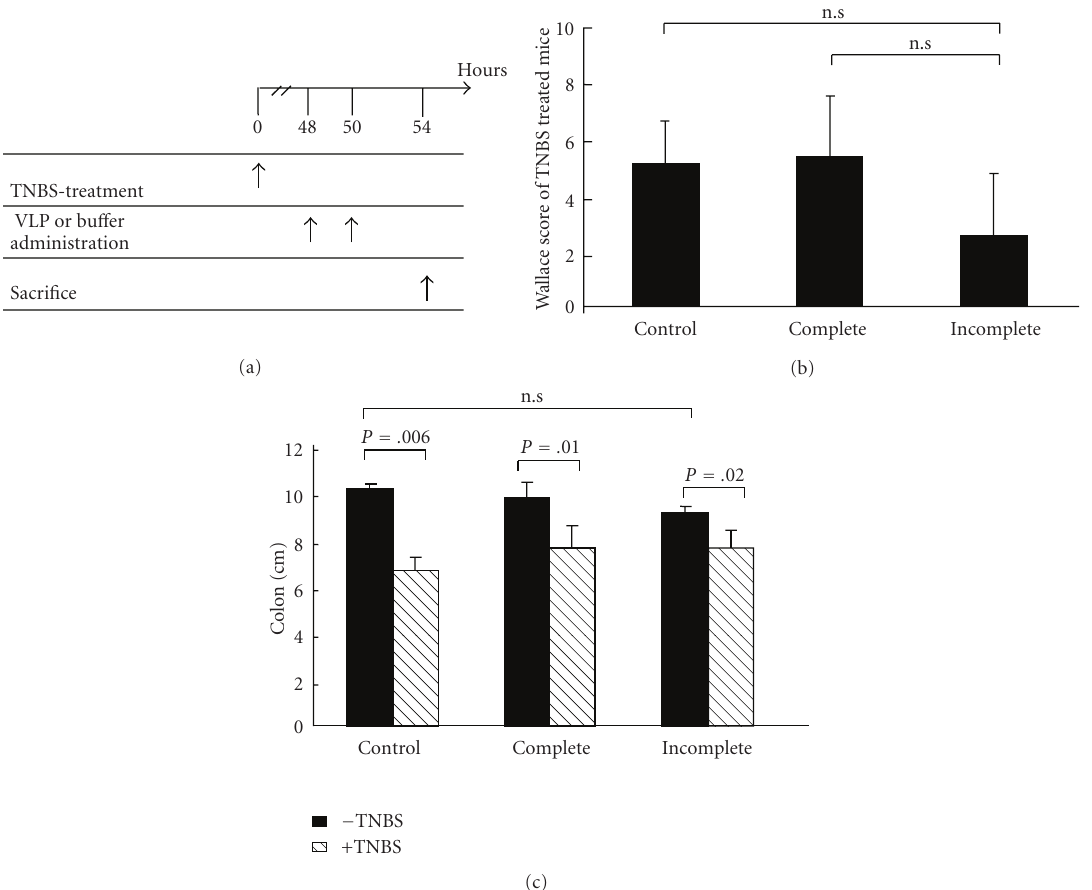
Figure 6: TNBS-induced colitis in the mouse model. (a) Scheme of the experimental protocol used for the induction of colitis in mice and time of complete or incomplete VLP administration, bu ff er administration, and sacrifice. (b) Colonic macroscopic damage according to the criteria of Wallace of TNBS-treated animals ( n = 4). (c) Comparison of colon length between control and TNBS-treated mice ( n = 4). Tukey-Kramer test was used to compare the di ff erence between means. Results are expressed as the means ± sd.